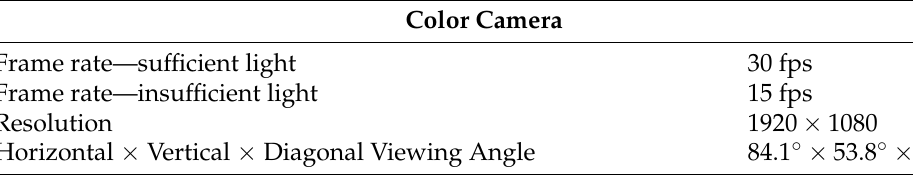
Table 4. Kinect v2 Selected Technical Specification.